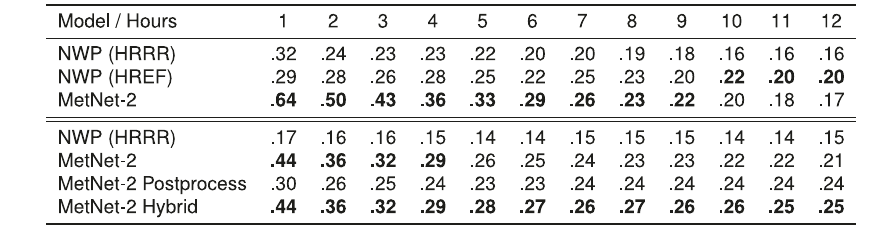
that includes all rates of gauge-corrected hourly cumulative precipitation. b EvaluationbasedonthecategoricalCSIforthe2mm/hrate(seeSupplementEfor other rates).